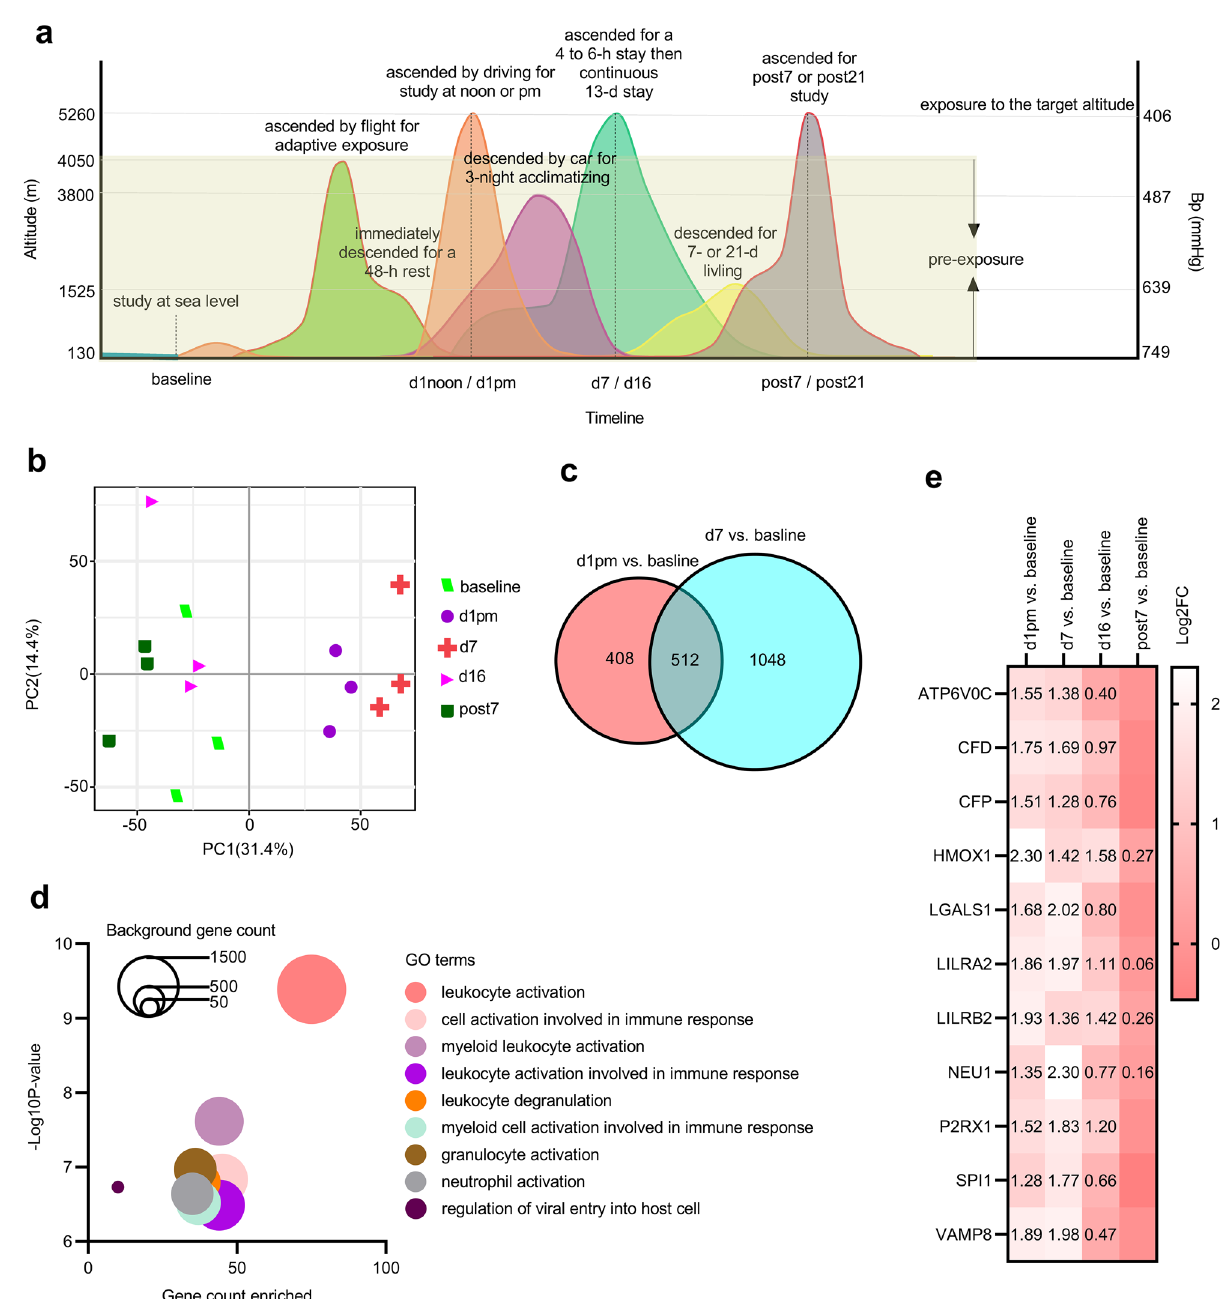
Figure 1. Acute exposure to VLH caused leukocyte activation. ( a ) Altitude-timeline plan of GSE103927. Subjects were studied at sea level for 30 days and then ascended to 4050 m by flight, followed by an immediate descent to 1525 m for a 48-h rest. After that, subjects ascended to the target altitude 5260 m for the d1 study at noon and pm, then decended to 3800 m for 3-night acclimatizing, allowing a 4- to 6-h exposure at the target altitude, then a continuous 13-day exposure at 5260 m for d7 and d16 studies. After that, subjects were allowed to stay at 1525 m again for 7 or 21 days and then reascended for the post7 or post21 study. ( b ) PCA for timeline gene expression patterns. ( c ) Venn analysis. ( d ) GO analysis. ( e ) Timeline changes in 12 DGs related to leukocyte